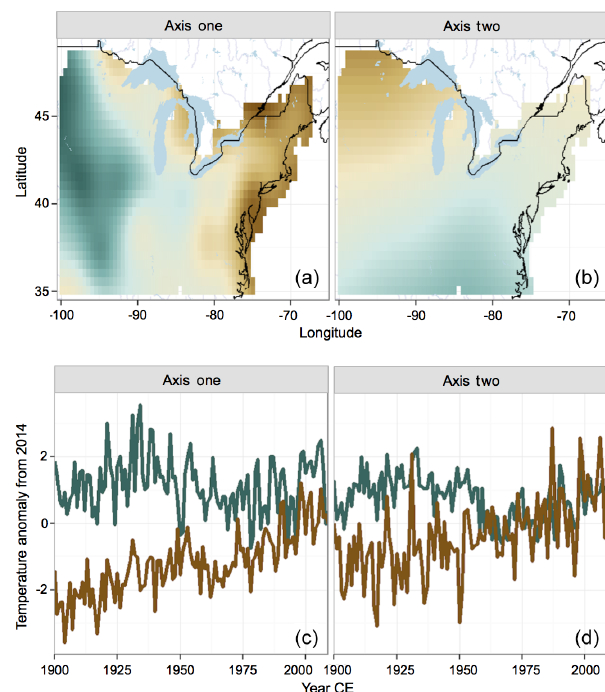
Figure 6. Broad-scale spatiotemporal patterns in the historical mean annual temperature anomalies from 1895–2010 from an em- pirical orthogonal function (EOF) analysis of data from the Global Historical Climatological Network for the NE US. (a) First EOF (16% of the variance) showing a strong west–east (longitudinal) gradient in temperature changes during the last century, with the west (northwest especially) showing an early- to mid-century maxi- mum and high variability (green line in panel c ) and the Atlantic margin showing strong warming throughout the century (brown line in panel c ). (b) Second EOF (accounting for 8% of the vari- ance) indicating warming in the northwest but with higher variabil- ity (brown line in panel d ) than along the Atlantic seaboard (brown line in panel c